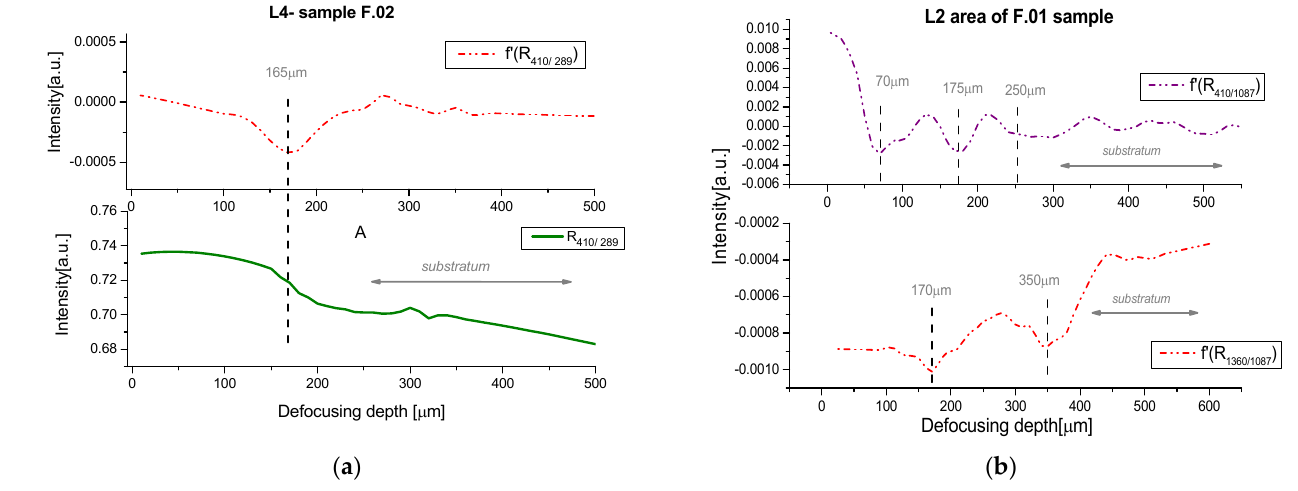
Figure 5. ( a ) Micro ‐ SORS image of the sample F.02; ( b ) F.02 in the L2 zone (white).